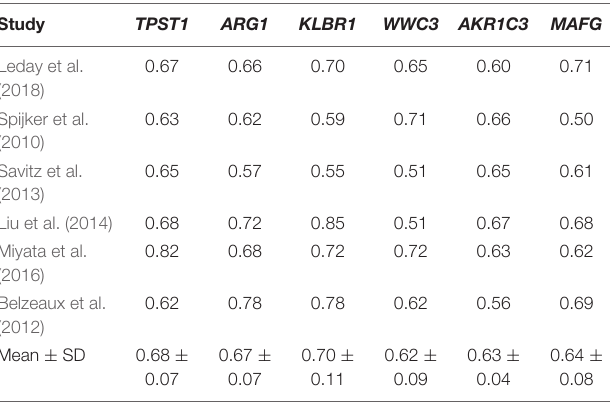
TABLE 2 | AUC of single gene models for MDD diagnosis.